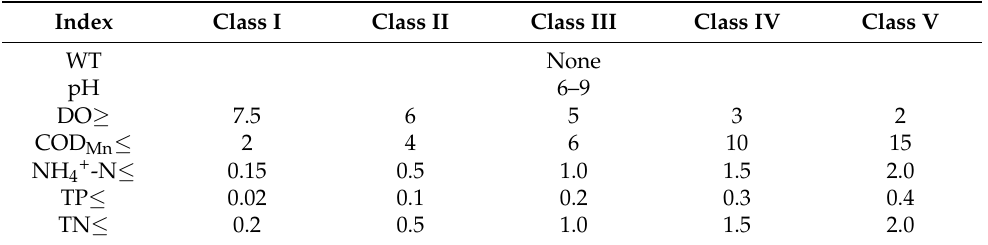
Table 2. Standard limits of fundamental indicators of surface water environmental quality standards (mg · L − 1 )